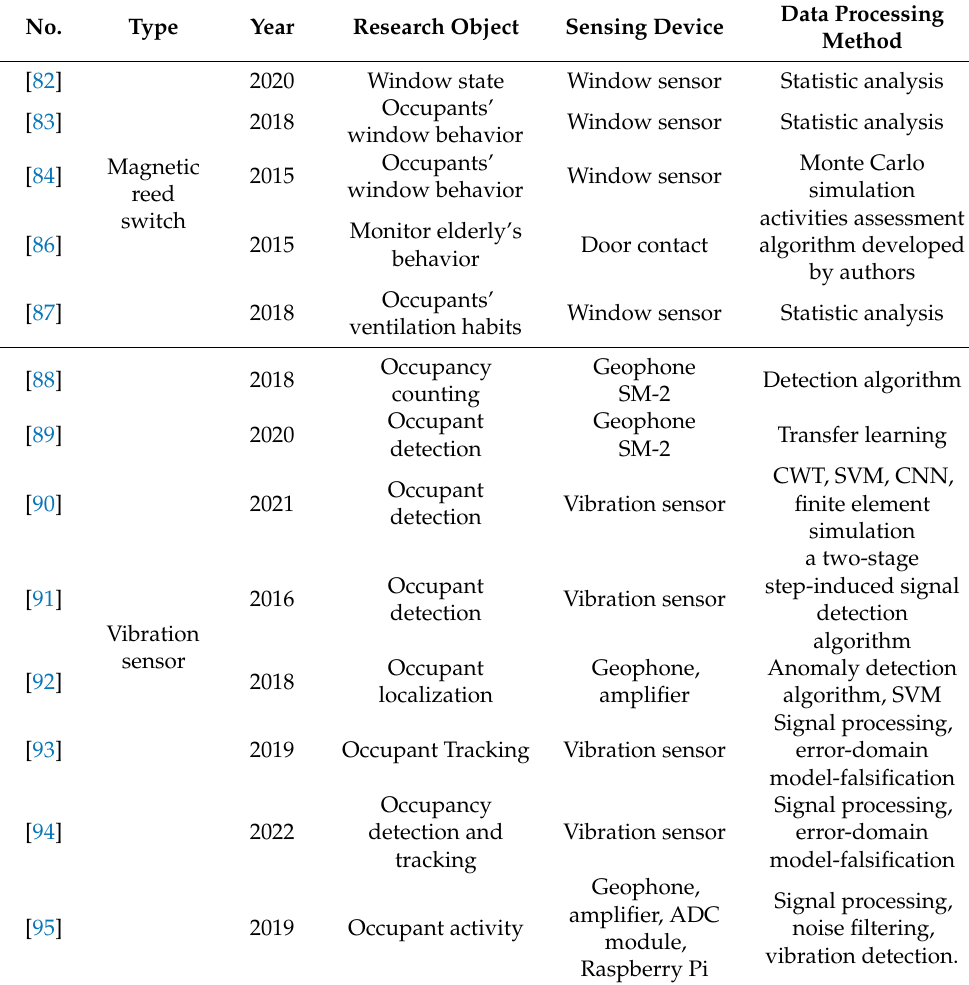
Table 6. The list of references for building components